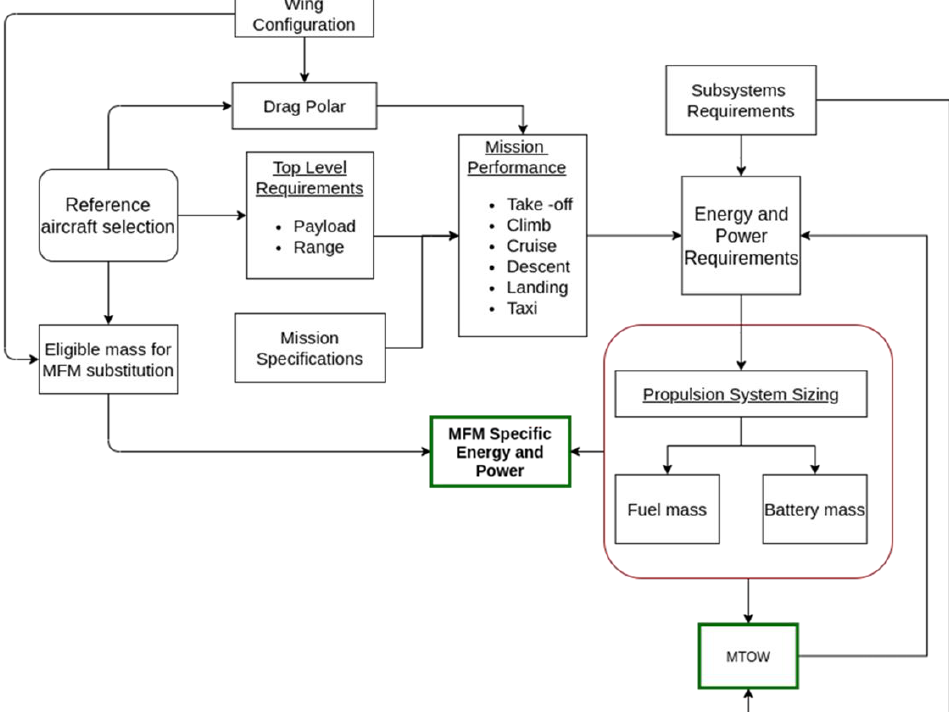
Figure 5. Aircraft sizing flow diagram (MTOW = maximum take-off weight, MFM = multifunctional